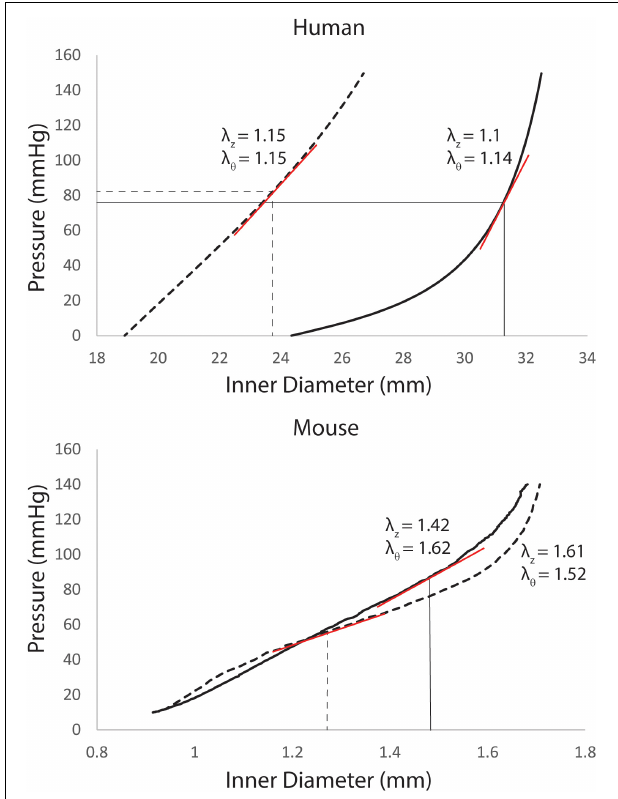
FIGURE 1 | Pressure-diameter curves for the ascending thoracic aorta (ATA) of young (dashed line) and old (solid lines) adult subjects with corresponding values of in vivo axial stretch ( λ z , from literature data) and circumferential stretch ( λ θ , iteratively calibrated). Linearized stiffness (red lines) were used in our FSI simulations. For the humans (top), curves are recreated from best-fit values of the 8 material properties from Roccabianca et al. (2014) with in vivo circumferential stretches adjusted until in vivo mean pressures corresponded with in vivo mean diameters. For the mice (bottom), the pressure-diameter curves were measured directly in vitro , with best-fit values of the material parameters determined via non-linear regression of the biaxial